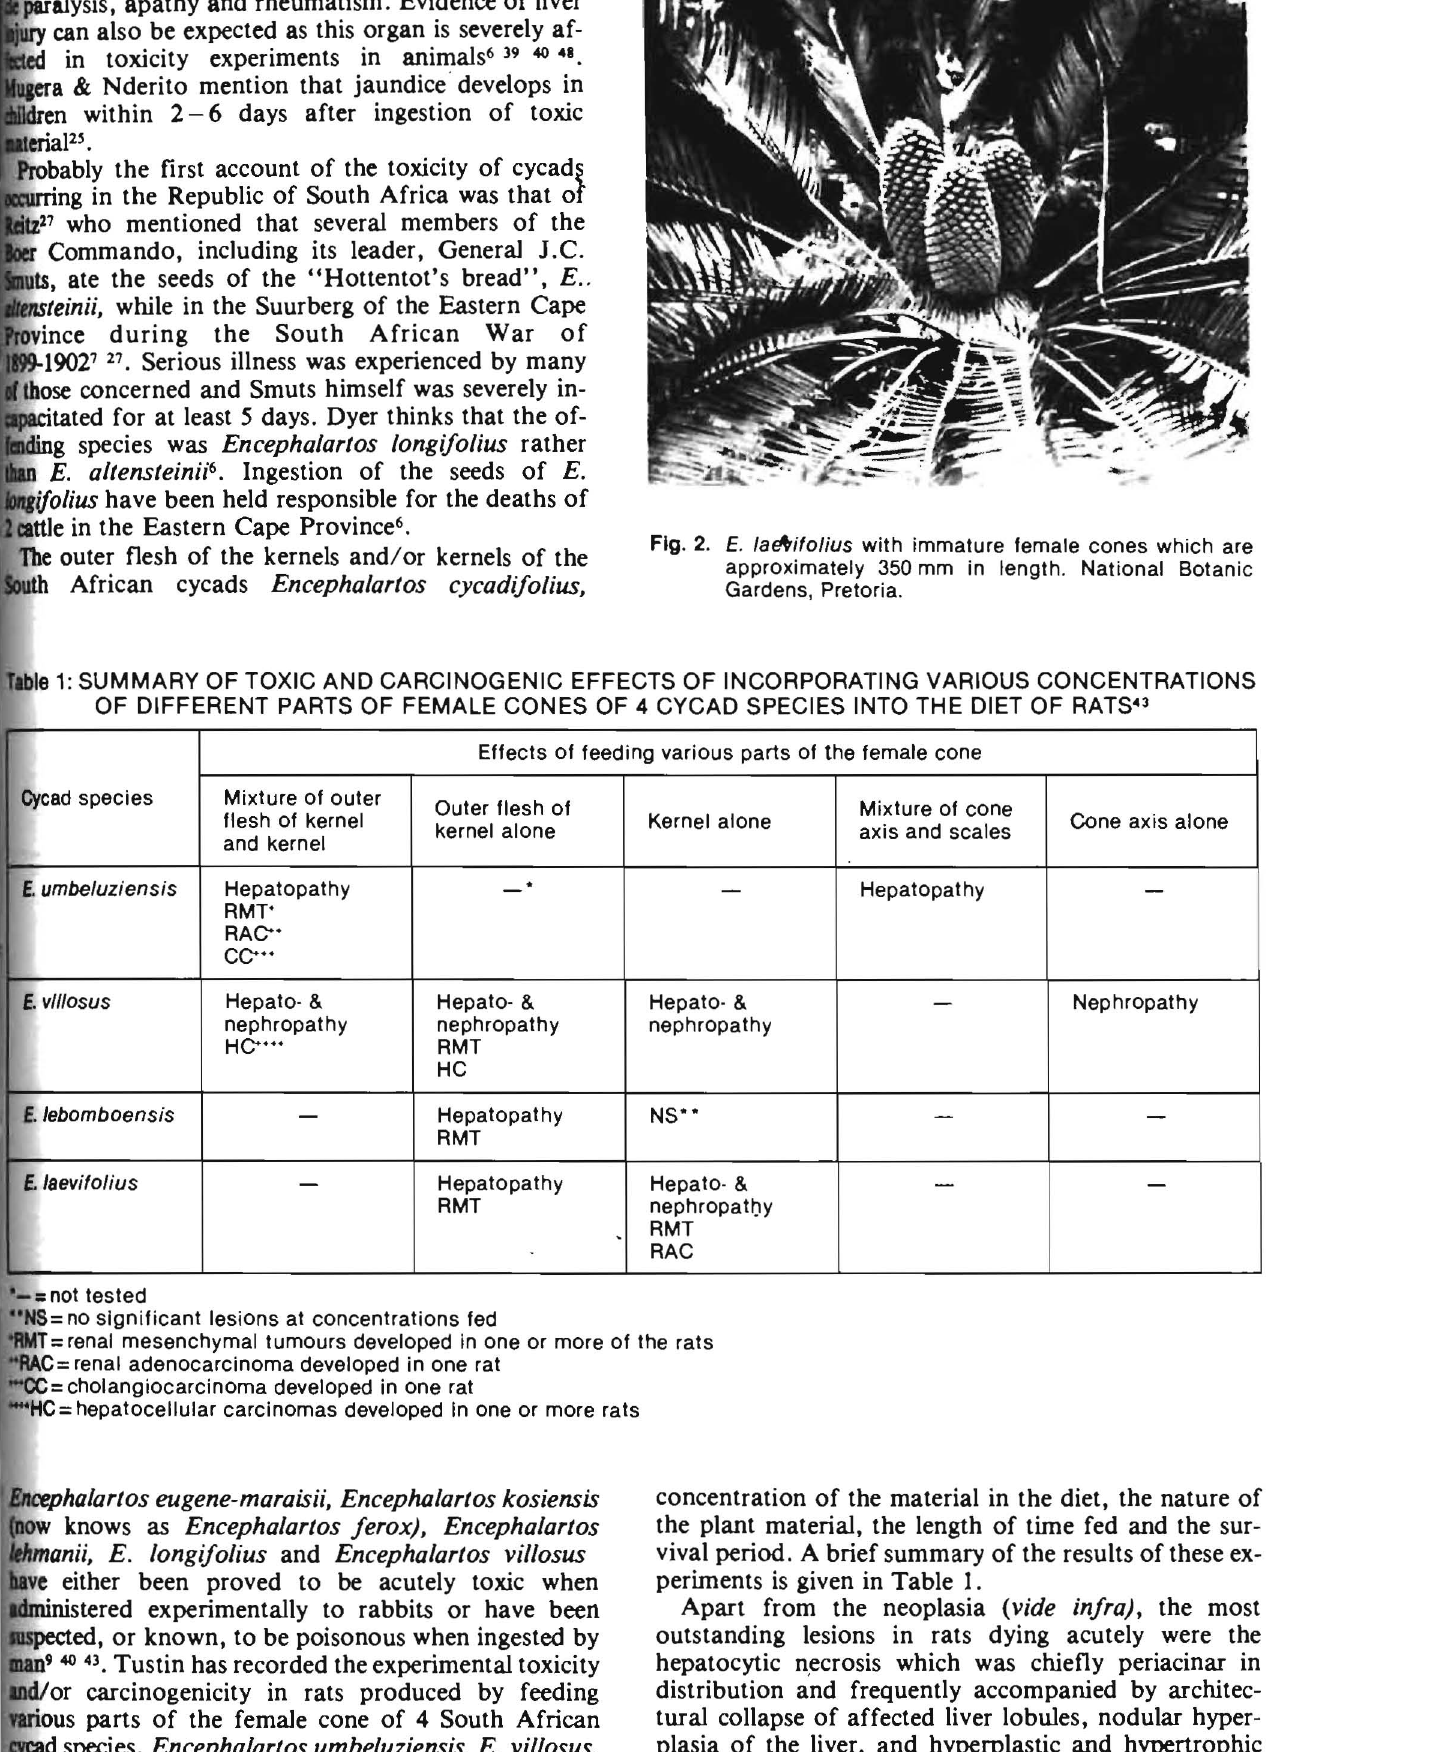
Fig. 2. E. lafl'lifolius with immature female cones which are approximately 350 mm in length. National Botanic Gardens,